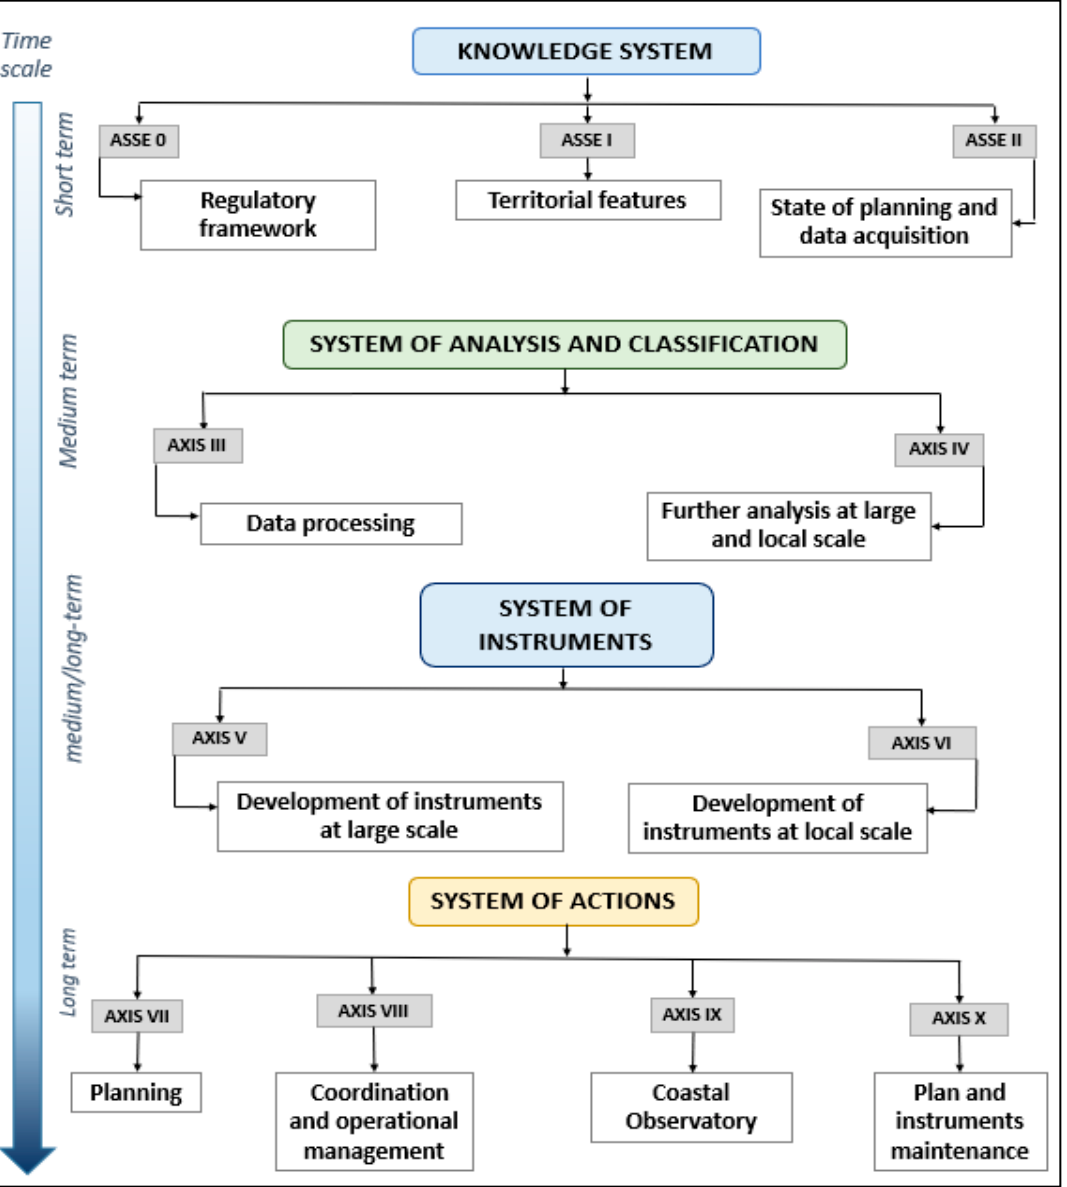
Figure 3. The framework of the methodology for integrated coastal zone management.